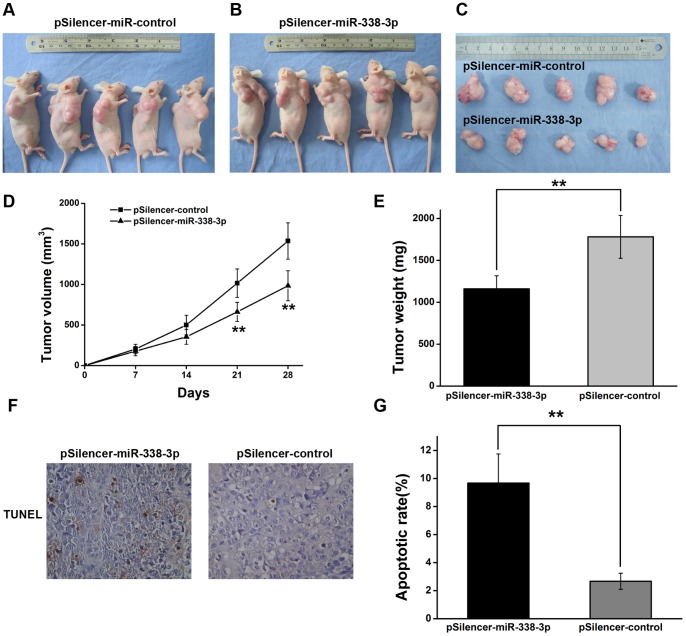
miR-338-3p inhibits tumorigenicity and increases apoptosis in vivo.
(A–C) Photographs of tumors derived for pSilencer-miR-338-3p or pSilencer-control vector stably transfected SGC-7901 cells in nude mice. (D) Growth kinetics of tumors in nude mice. Tumor diameters were measured every 7 days (**P<0.01). (E) Average weight of tumors in nude mice. Means ± S.D. were shown (**P<0.01). (F) Representative photographs of TUNEL assay of tumor specimens from nude mice (magnification, 200×). (G) The percentage of apoptotic cells was counted. Means ± S.D.(**P<0.01).